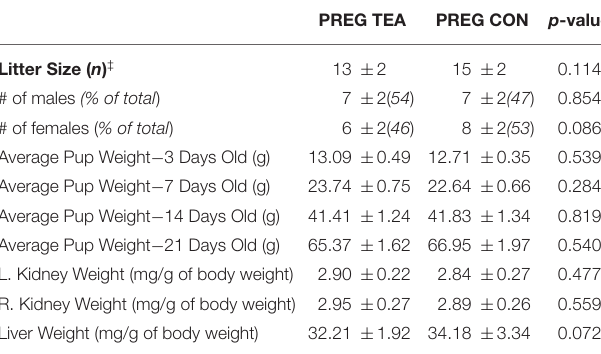
TABLE 1 | Litter characteristics and maternal organ weights at 4 months